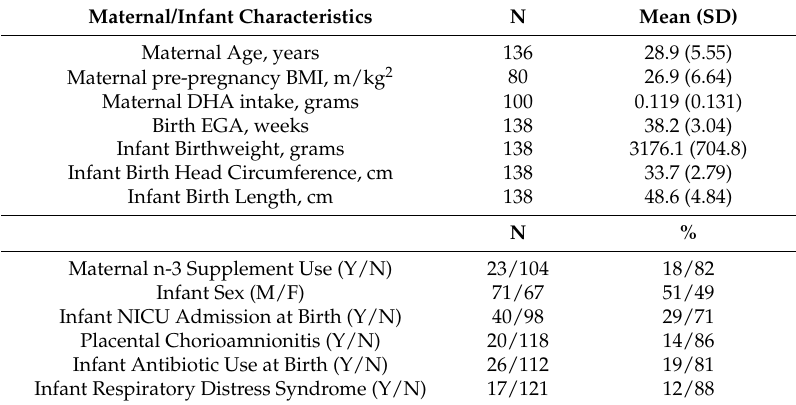
Table 1. Participant